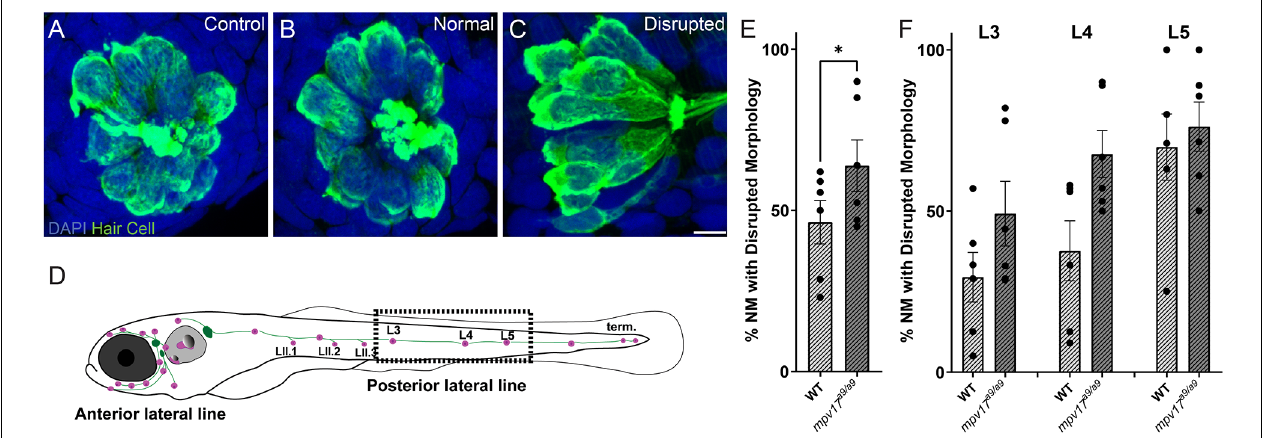
FIGURE 5 | Mechanical overstimulation results in morphological disruption of neuromasts more frequently in mpv17 a9/a9 larvae than in WT. (A–C) Maximum-intensity projections of confocal images showing hair cells labeled with Parvalbumin and all nuclei labeled with DAPI in control neuromasts (A) and strong water current exposed neuromasts with normal (B) or disrupted (C) morphology. (D) Schematic of larval zebrafish indicating the placement of neuromasts (pink dots) and afferent nerves (green lines). Neuromasts L3, L4, and L5 (dashed rectangle) were examined in this study. (E,F) Quantification of disrupted neuromasts, both overall (E) and separated by position on the body (F) . Each point indicates the percentage of neuromasts with disrupted morphology in a single experimental trial. The frequency of disrupted neuromasts was higher in the more posterior L5 neuromasts; mpv17 a9/a9 neuromasts showed disrupted morphology more frequently than WT (* P = 0.0232). n = 9–64 neuromasts (L3, L4, and L5) per trial; N = 6 experimental trials. Scale bar: 5 µ m. Error bars: